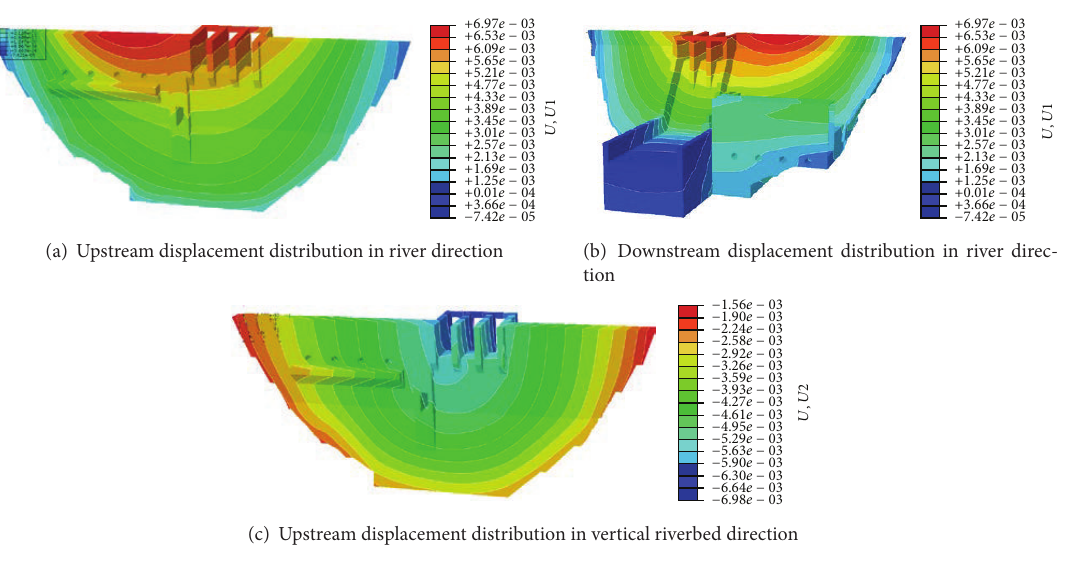
Figure 4: Dam displacement contour in various directions under analysis Case 1 (unit: